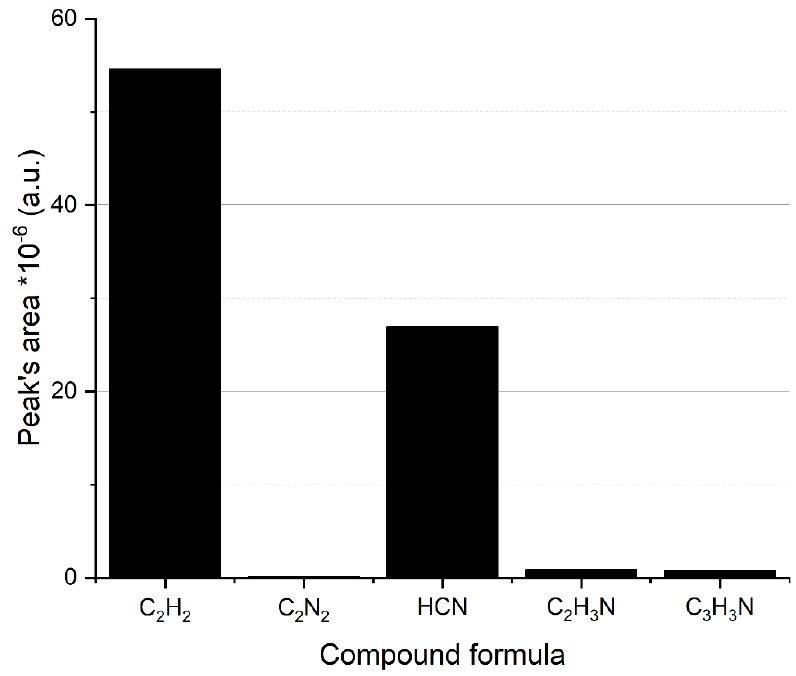
Figure 9. Nitrogen-containing compounds detected in the outlet gas (with C 2 H 2 as reference).